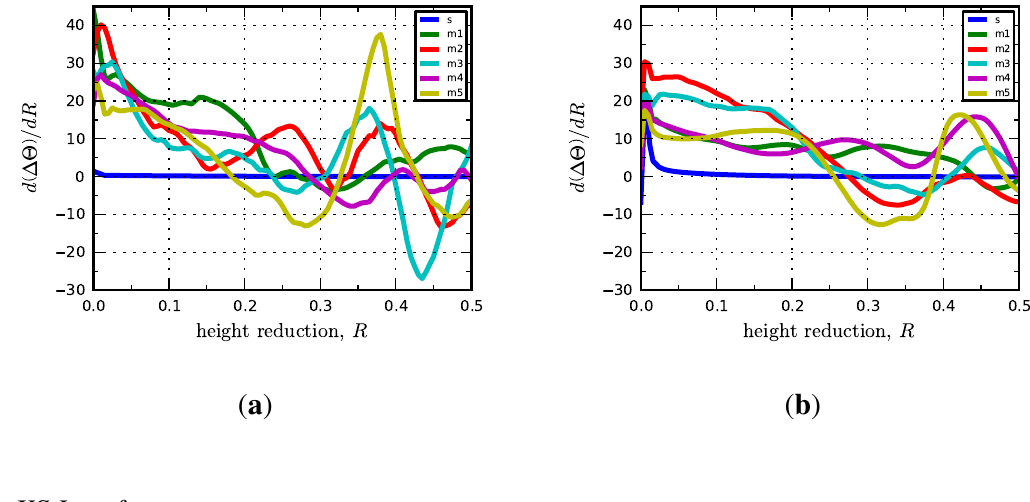
Figure 8. Lattice reorientation rate plotted as a function of height reduction for the ( a ) copper phase in the Brass-I interface; and ( b ) niobium phase in the Brass-I interface. In the legend, “s” refers to the periodic bicrystal simulations and the “m1, m2, ...” refer to the different realizations of the multicrystal